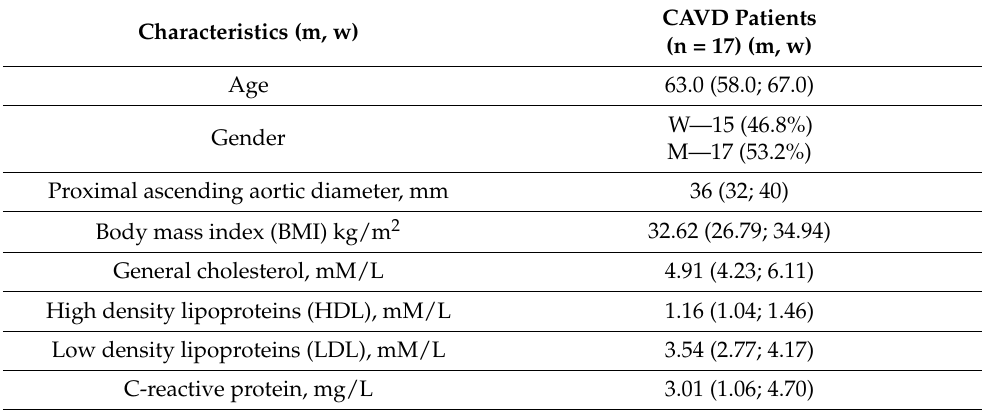
Table 1. Clinical data of the